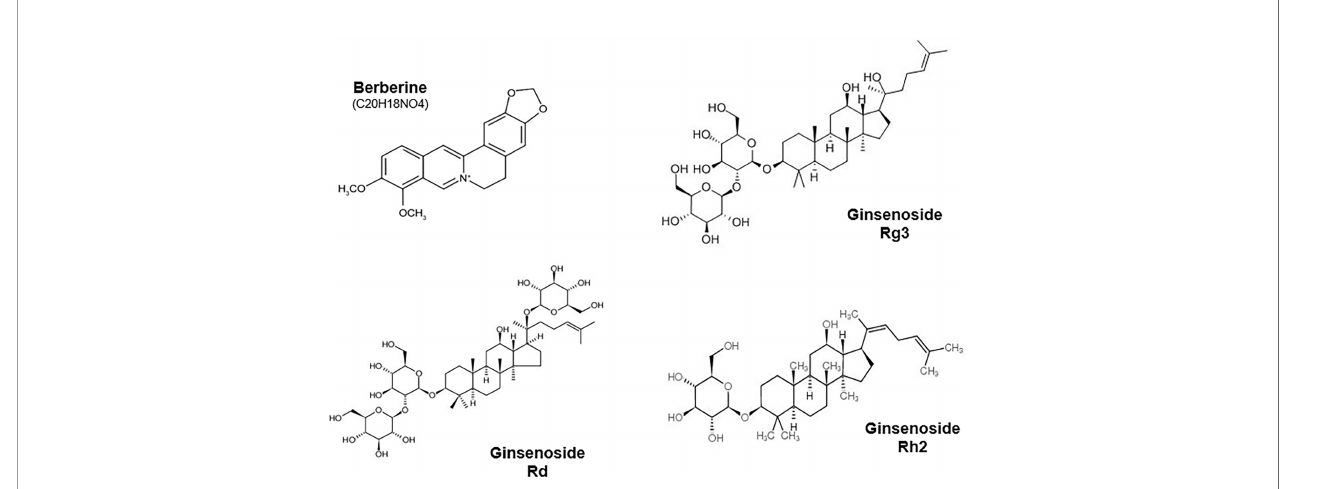
FIGURE 3 | Chemical structure of berberine and Ginsenosides Rh2, Rg3 and Rd.